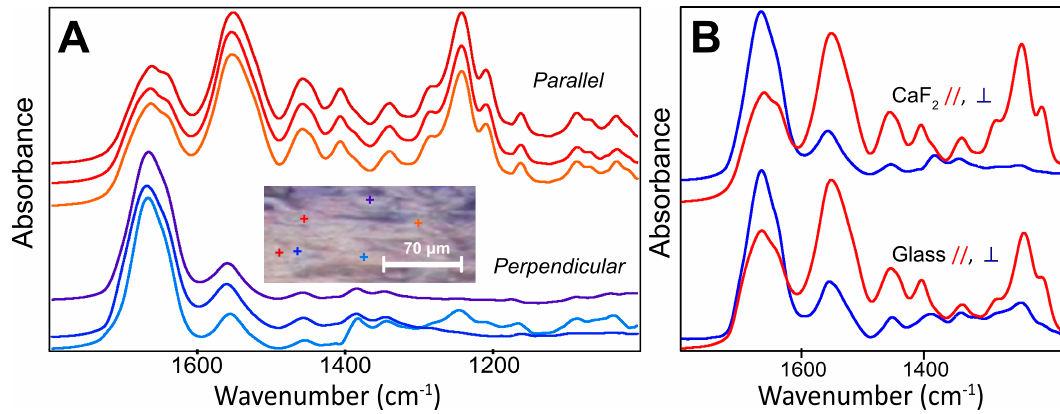
Figure 2. Optical photothermal IR (O-PTIR) spectra from intact tendon, from ~500 nm measurement spots. ( A ) Individual spectra obtained from the two orientations of a section mounted on a CaF2 window, relative to the linearly polarized quantum cascade laser (QCL). Inserted visual image shows the 6 locations, all of which lie within the region imaged with FTIR FPA; scale bar = 70 μ m. Colored + correspond to spectral colors. ( B ) Comparison of spectra obtained from CaF2 (top) and glass (bottom) substrates in parallel and perpendicular orientations to linearly polarized QCL.